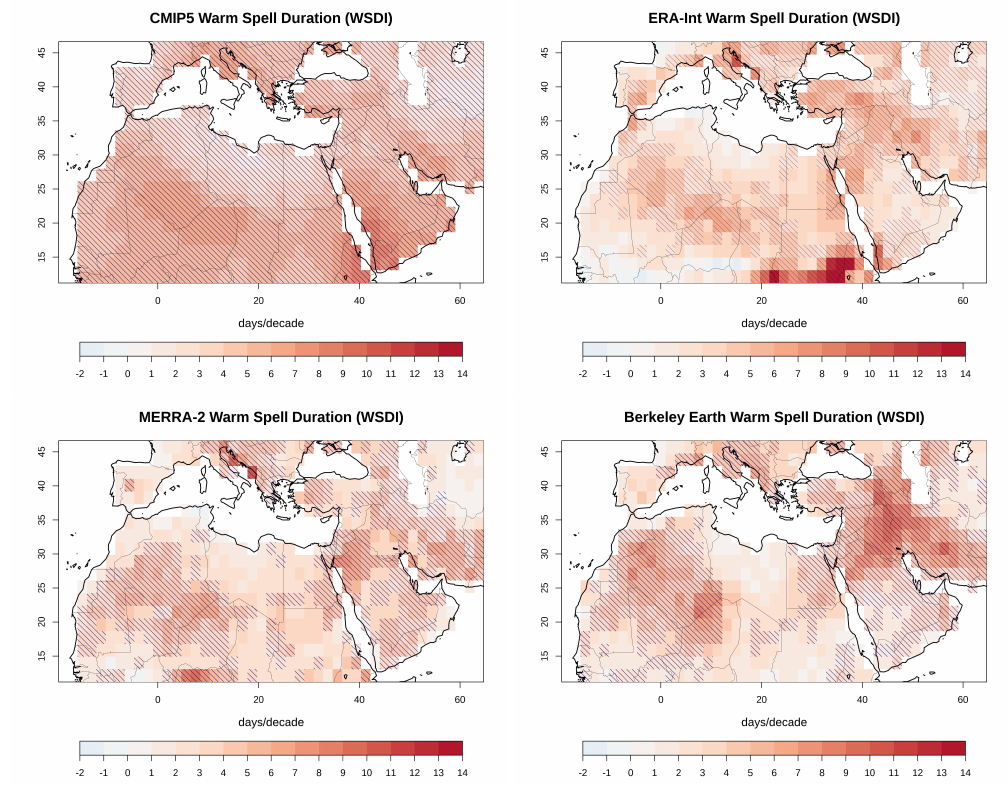
Figure 7. 1980–2018 decadal trend of the Warm Spell Duration (WSDI) for the: CMIP5 multi-model ensemble mean ( top left ), ERA-Interim ( top right ), MERRA-2 ( bottom left ), and Berkeley Earth ( bottom right